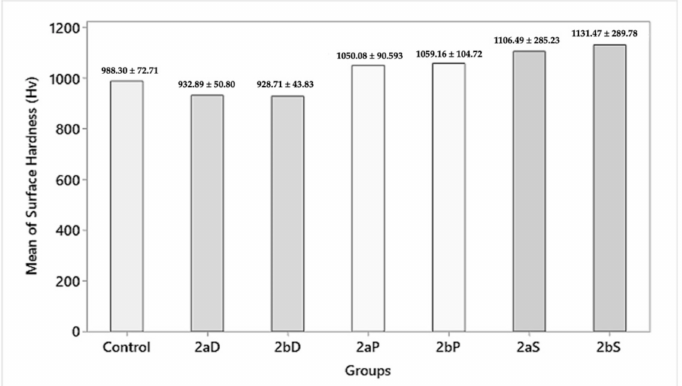
Figure 9. Surface hardness after polishing procedures (HV).